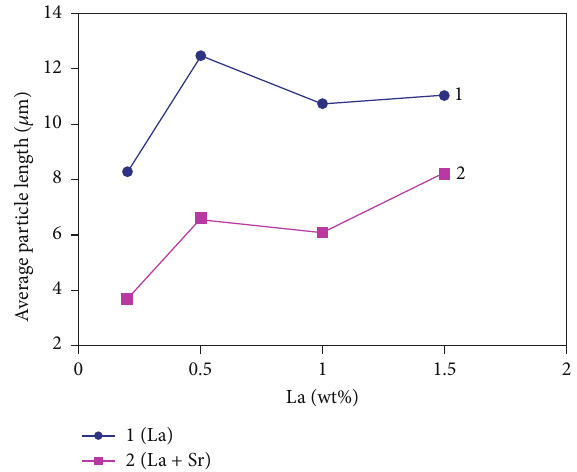
Figure 18: Effect of La and La + Sr on the average Si particle length in 413